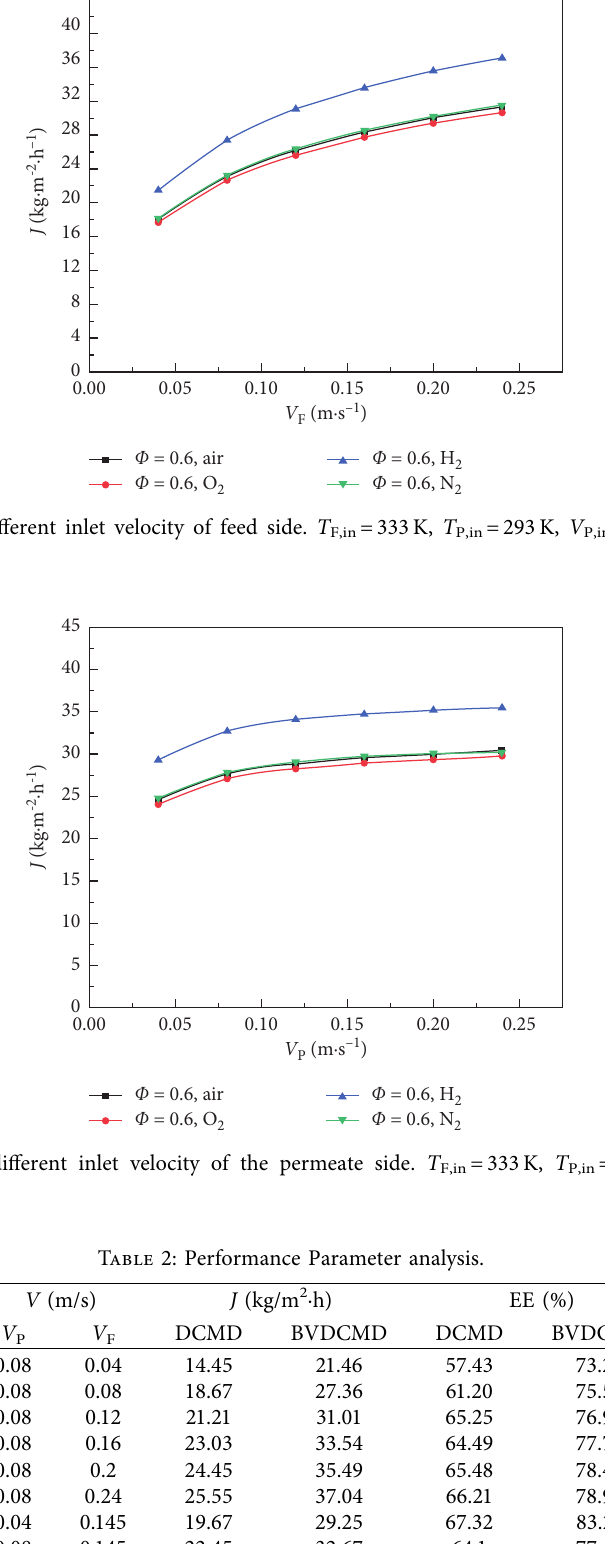
Table 2: Performance Parameter